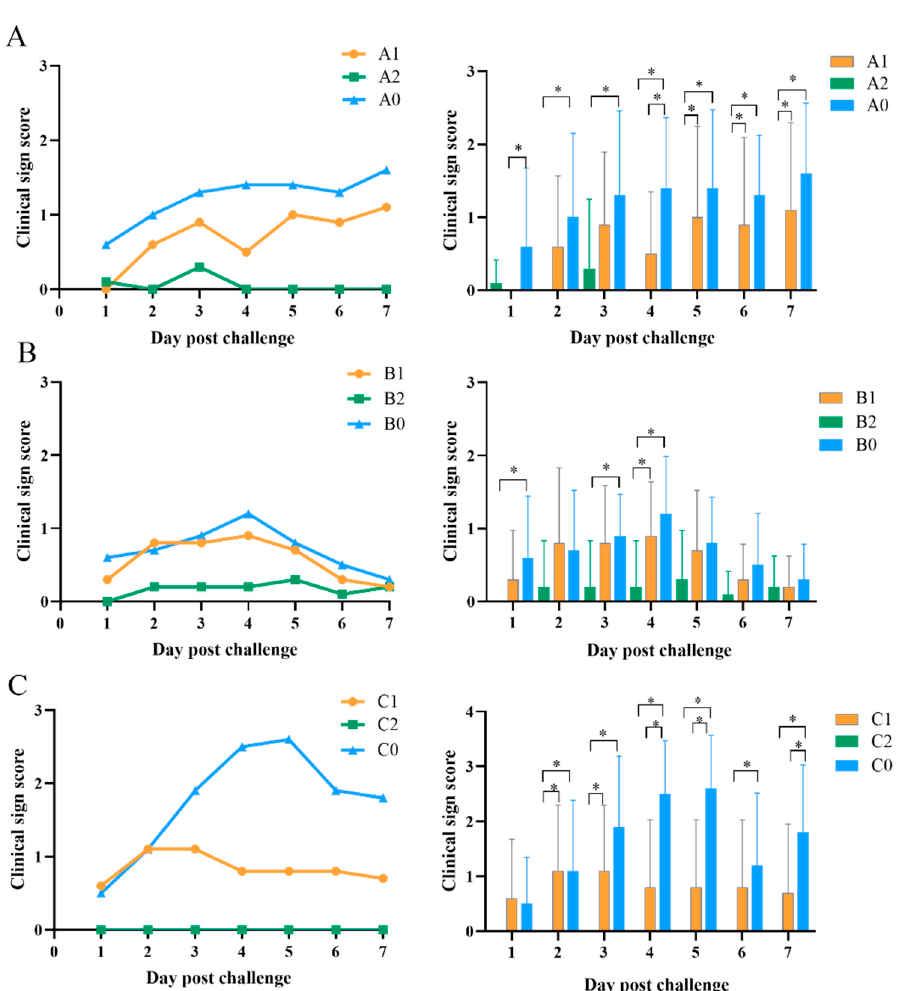
Figure 2. Clinical sign scores of chickens after challenge with Av. paragallinarum. Clinical signs scores (n = 10) were monitored daily for 7 days after challenge with 2019 − HB65 ( A ), 2019 − HB68 ( B ), and 2020 − JS80 ( C ) at 130 days old. Data in line graphs are presented as means. Data in bar graphs indicate means ± standard deviations. * p < 0.05.